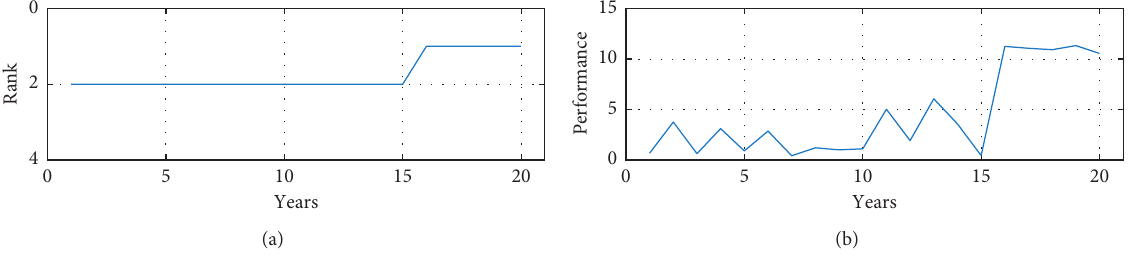
Figure 6: Rank history (a) and performance (b) of agent 119. During the simulation the employee 119 improves his/her rank.